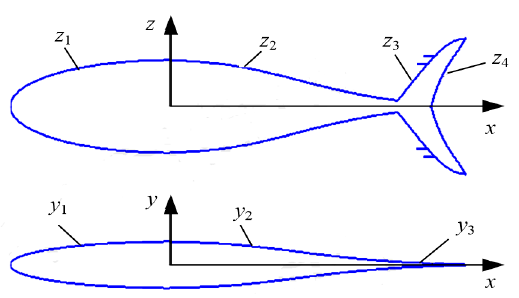
Figure 2. Cross-sectional shape of the geometric model.